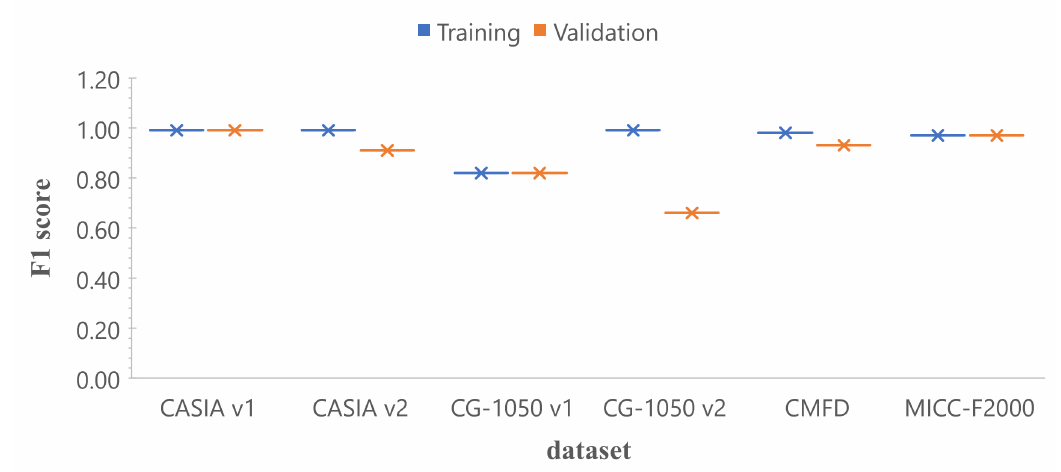
Figure 8. Comparison in terms of F1 score with a single dataset (training vs. validation). The x -axis corresponds to the model trained with the specific dataset, and the y -axis is the F1